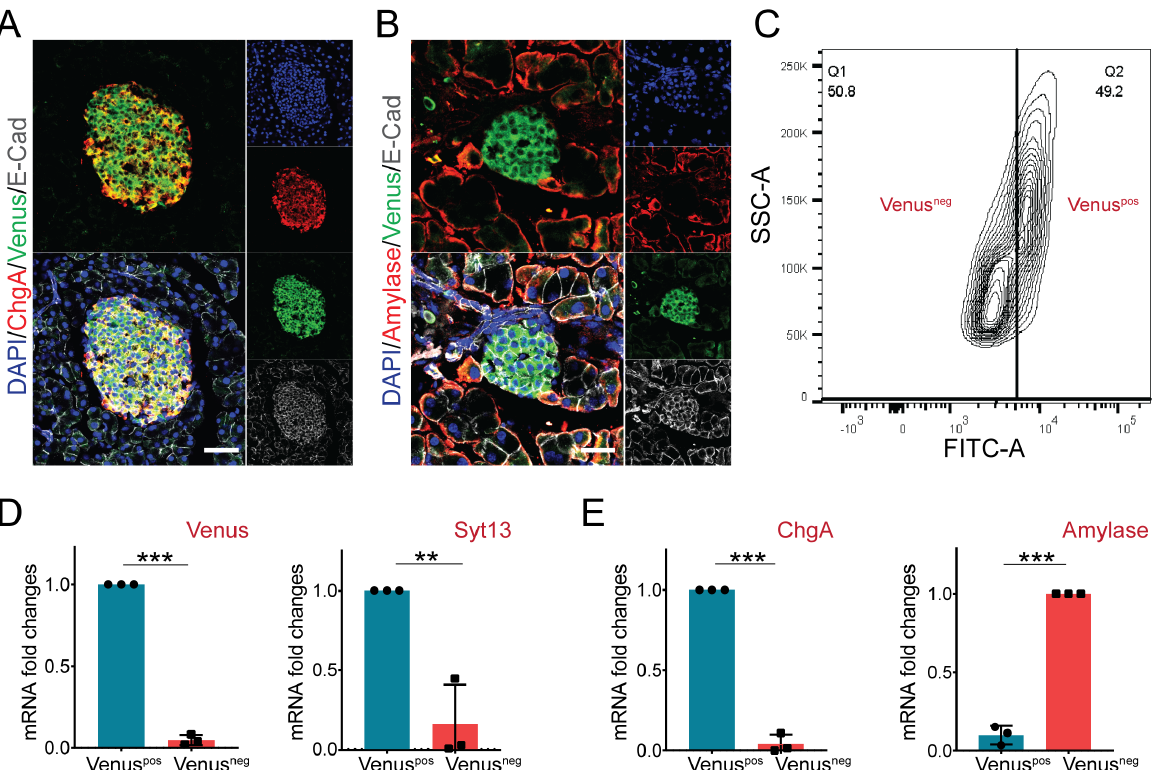
Figure 4. Syt13-VF expression in the adult pancreatic cells. ( A ) Immunostaining analysis of Syt13-VF expression in ChgA-expressing islet cells in pancreatic sections prepared from the reporter mice. Scale bar 20 µ m. ( B ) No colocalization between Syt13-VF and amylase-expressing cells is detected. Scale bar 20 µ m. ( C ) Representative FACS plot indicating the successful separation of Venus-positive (Venus pos ) cells from Venus-negative (Venus neg ) cells. ( D ) qPCR analysis shows high expression levels of Venus and Syt13 in Venus pos cells isolated by FACS ( n = 3). ( E ) qPCR analysis indicated high expression levels of ChgA and amylase in Venus pos and Venus neg cells, respectively ( n = 3). (** p < 0.01;*** p < 0.001; t -test). Data are represented as mean ±